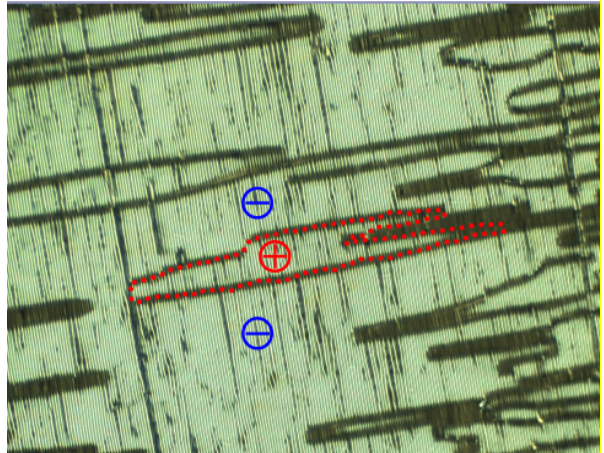
Figure 4. A 2 μ m commercial (ECH ®, Japan) planar-aligned cell in the N X phase [16]. Stripes observed are parallel to the rubbing direction. Discontinuities in the stripe pattern indicate the domain boundaries of opposite chirality. Identification of the chirality became possible via application of an electric field. The area marked by red dots corresponds to the domain of a single chirality, for example.